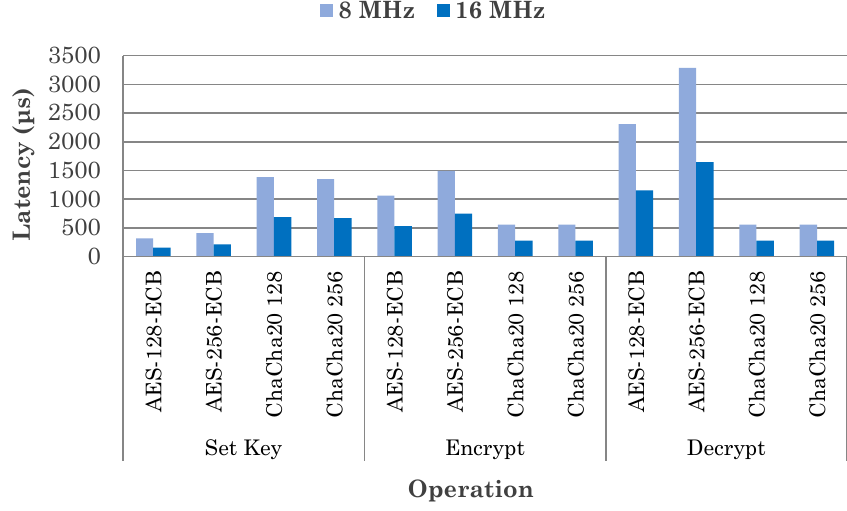
Figure 6. Comparison of latency in different operations of AES and ChaCha cryptography